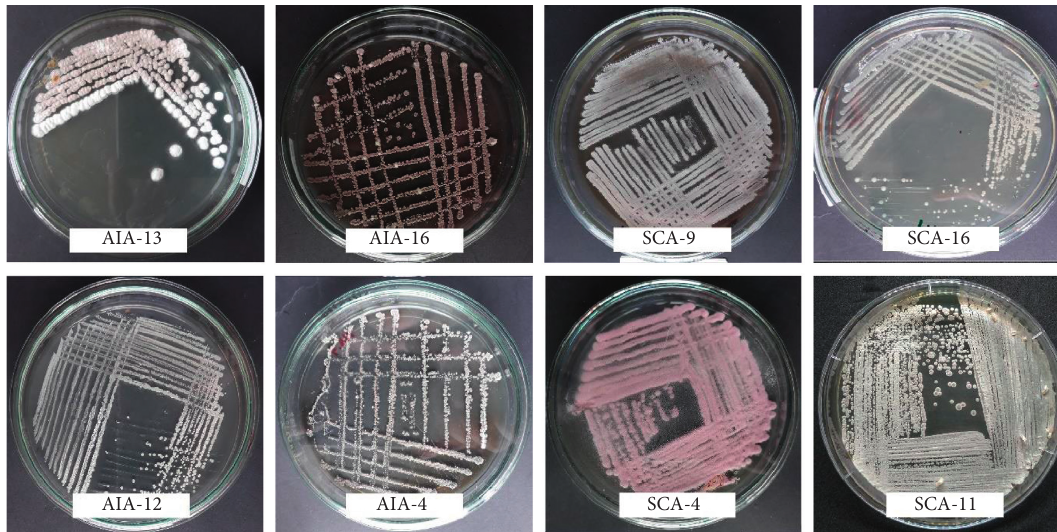
Figure 1: Morphological diversity of presumptive Streptomyces isolates in yeast-malt extract agar (ISP-2